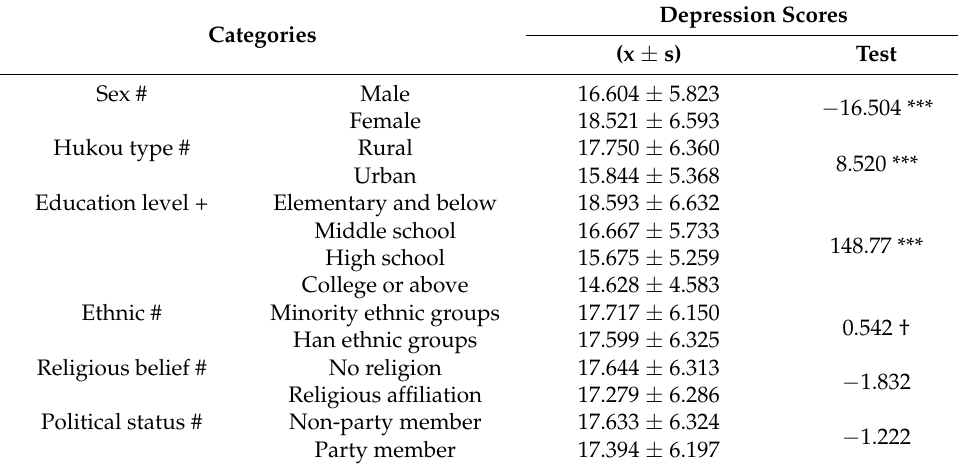
Table 2. The depression scores by demographic characteristics (N = 11,564).